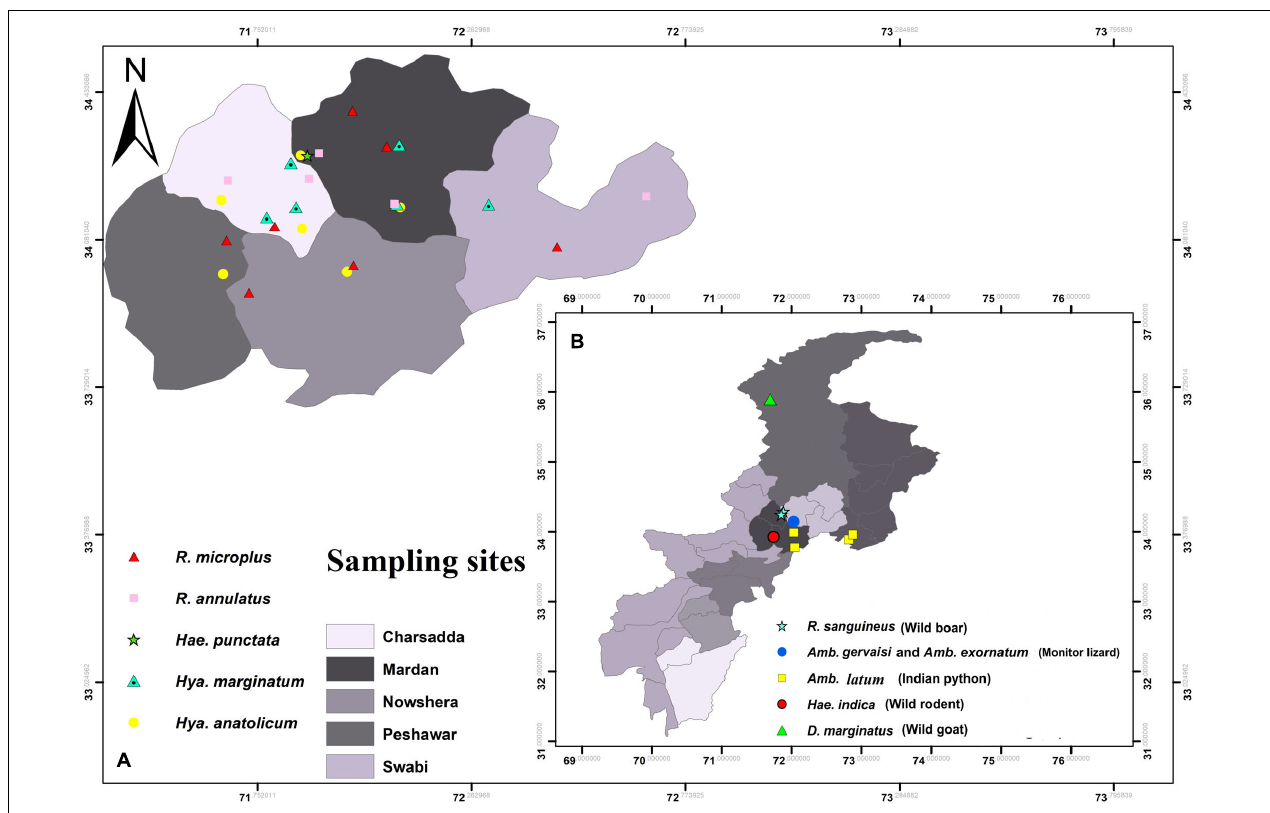
FIGURE 2 | Map showing locations of ticks (A) collected from humans (B) and wild animals.